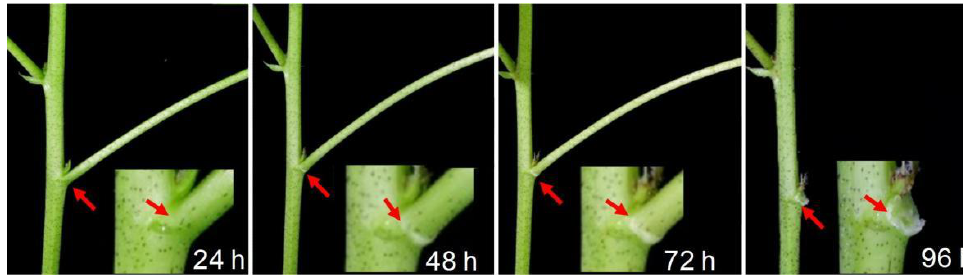
Figure 1. Effect of thidiazuron (TDZ) on cotton leaf abscission at 24, 48, 72, and 96 h after treatment; 750 mg/L TDZ was applied evenly to the whole plants at the six-leaf stage. The pictures were taken at 24, 48, 72, and 96 h, respectively, after treatment.